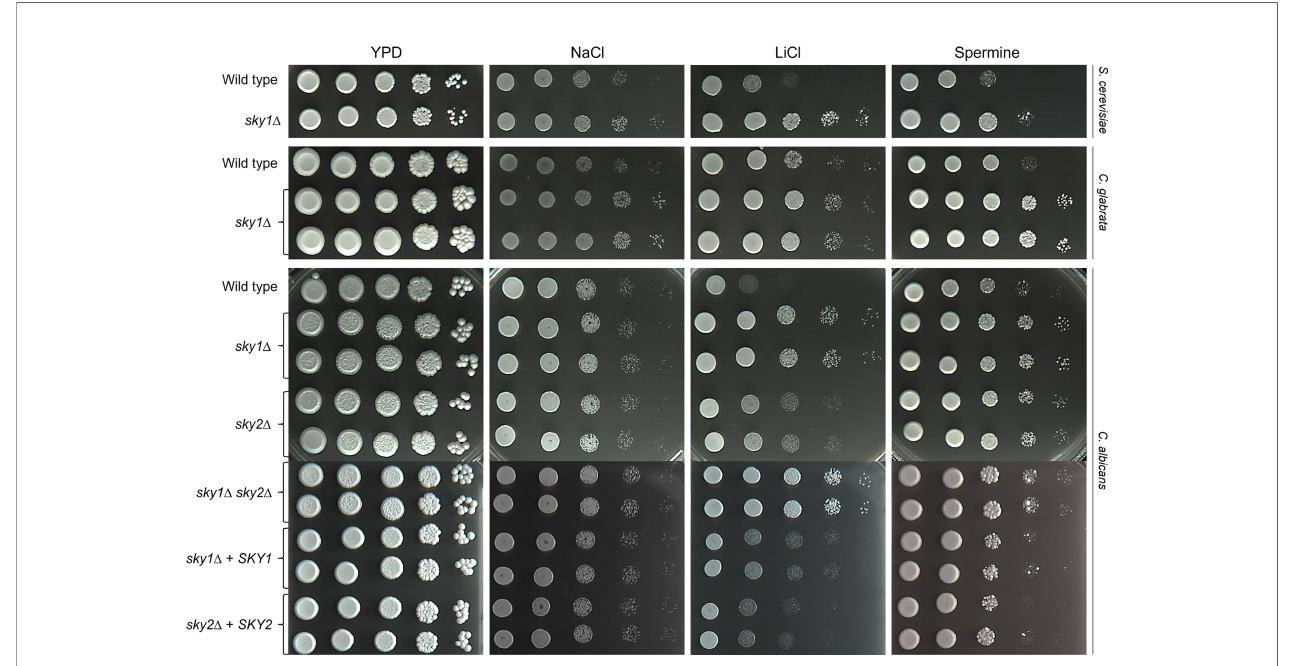
FIGURE 2 | Growth of S. cerevisiae and C. glabrata sky1 D mutants and of C. albicans sky1 D and sky2 D mutants on high salt and toxic spermine levels. YPD overnight cultures of the strains were adjusted to an optical density (OD 600 ) of 1.0. For C. albicans and C. glabrata two independently generated mutants were tested. Serial 10-fold dilutions were spotted on YPD agar plates containing the indicated stressor and incubated for 2 – 3 days at 30°C ( S. cerevisiae ) or 37°C ( C. albicans and C. glabrata ). S. cerevisiae / C. glabrata / C. albicans plates contained NaCl (1 M/1.7 M/1.8 M), LiCl (0.3 M/0.18 M/0.5 M) or spermine (2 mM/8 mM/12.8